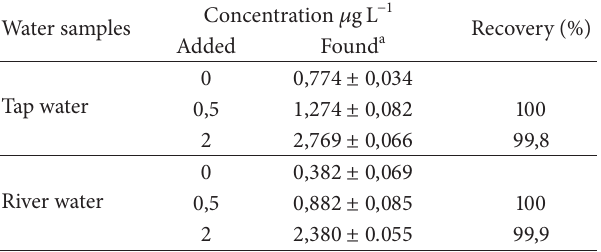
Table 10: Analytical results for the determination of Hg(II) in natural water samples by